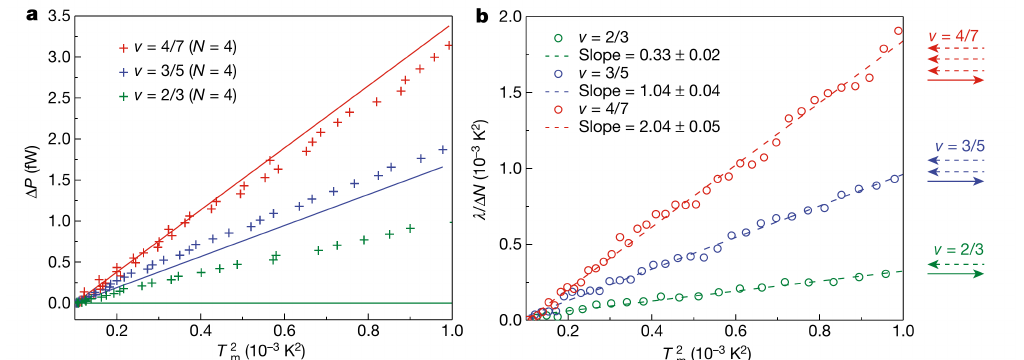
Figure 9: Measurement of thermal current for Jain states with both chiral and an- tichiral edge excitations at ν = 2 / 3,3 / 5,4 / 7 [ 38 ] : (a) Power dissipation ∆ P as a function of T 2 for N = 4 edges versus (118) with | c − ¯ c | predicted values for the up- and down-stream modes shown on the right; (b) Difference of power dissipations between N = 4 and N = 2 edges and linear fits determining the experimental | c − ¯ c | values in